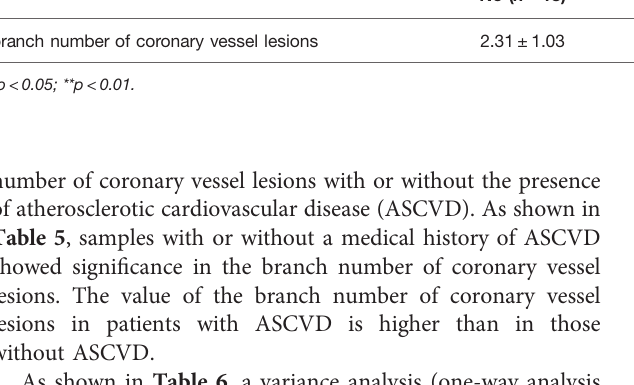
TABLE 5 | Variance analysis of the branch number of coronary vessel lesions and medical history of atherosclerotic cardiovascular disease. Medical history of atherosclerotic cardiovascular disease (mean and